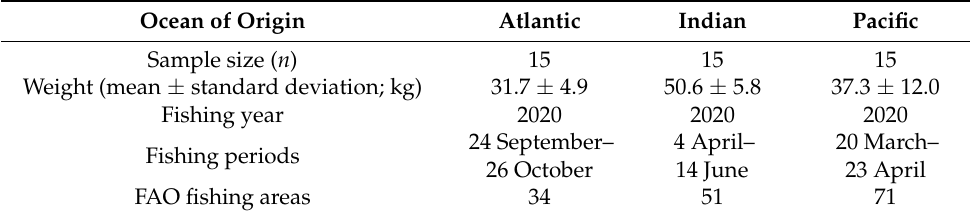
Table 1. Yellowfin tuna weight, fishing period and fishing